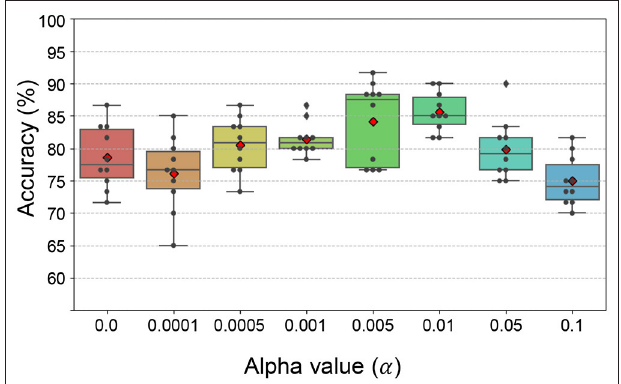
FIGURE 6 | The classification accuracy with varying α values. The classification accuracy was the highest with α = 0.01.